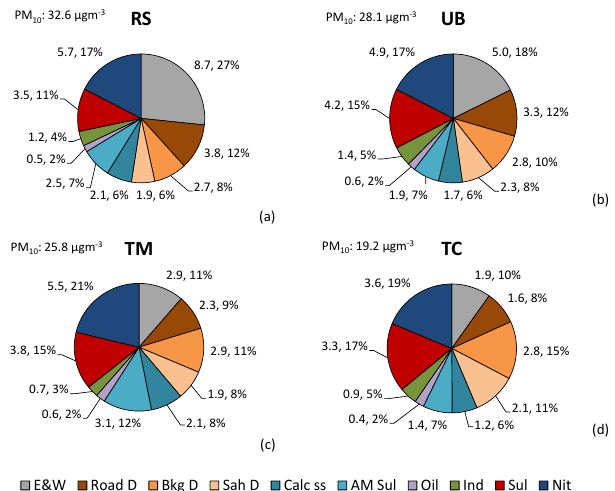
Figure 9. Sources contributing to the PM 10 load extracted with the PMF tool and subcomponents at each monitoring: (a) RS, (b) UB, (c) TM and (d) TC. Exhaust& wear (E & W), road dust (Road D), heavy oil (Oil), industrial (Ind), sulfate (Sul) and nitrate (Nit) are direct PMF factors. The mineral factor was broken into background dust (Bkg D) and Saharan dust (Sah D) and the aged marine factor into calculated sea salt (Calc ss) and anthropogenic marine sulfate of regional origin (AM Sul). Data are given in µgm − 3 and %. The average PMF PM 10 concentrations are represented at the top left of each graph for each